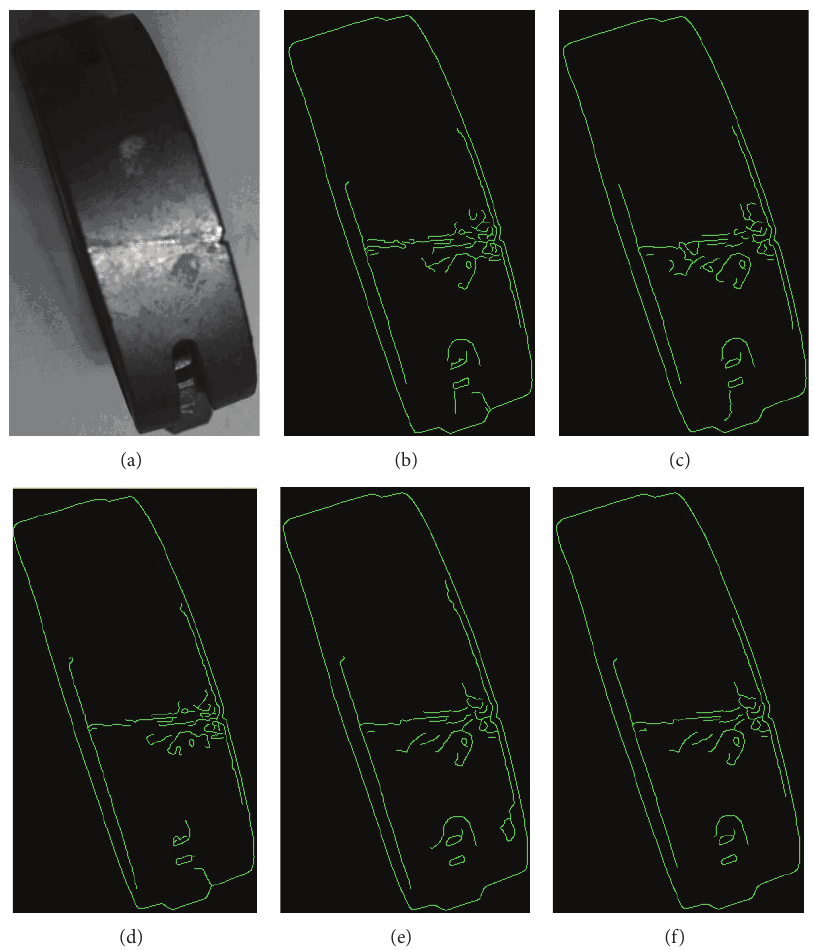
Figure 12: The original image (a) and segmentation images with different iteration numbers